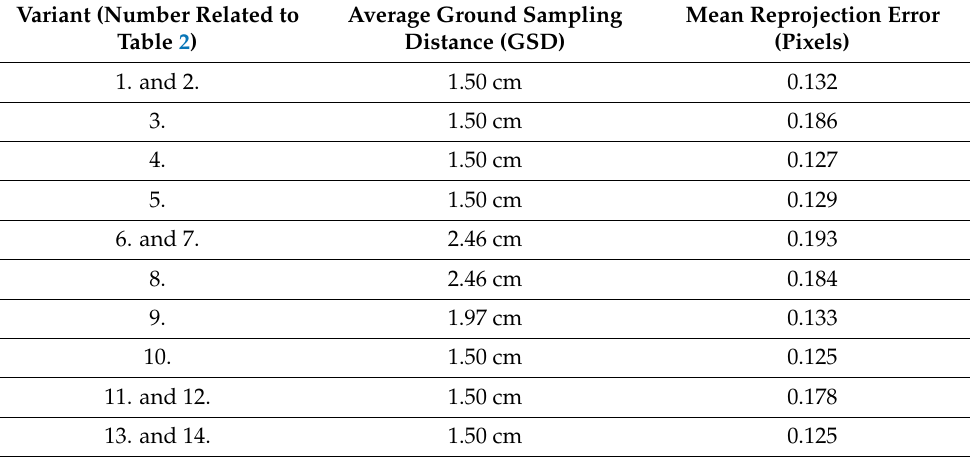
Table 4. Bundle Block Adjustment Details. The average of the reprojection error in